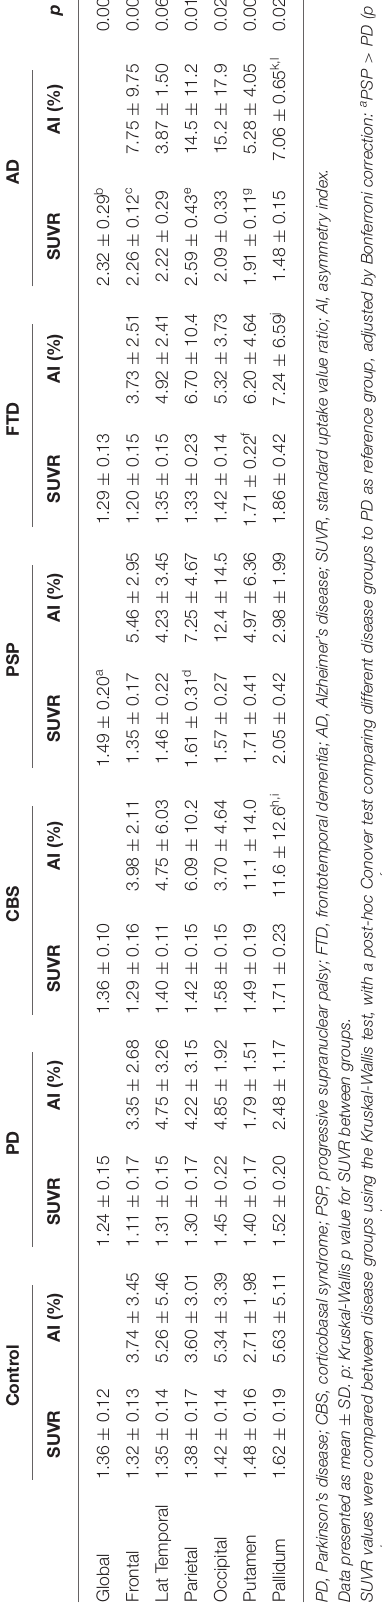
(coefficient = 0.118, 95% CI: − 0.0001–0.235, p = 0.0502) ( Figure 3C ) and occipital (coefficient = 0.077, 95% CI: − 0.001– 0.156, p = 0.053) ( Figure 3E ) regions. However, there was no obvious association between plasma tau and SUVR in the putamen or pallidum ( Figure 3F ). Furthermore, the correlation between regional cortical SUVR value and plasma tau level still remained globally (regression coefficient = 0.129, p = 0.044) and in the frontal (coefficient = 0.152, p = 0.024) and parietal (coefficient = 0.146, p = 0.04) regions after adjusting for age and sex in the multiple-regression model ( Supplementary Table 2